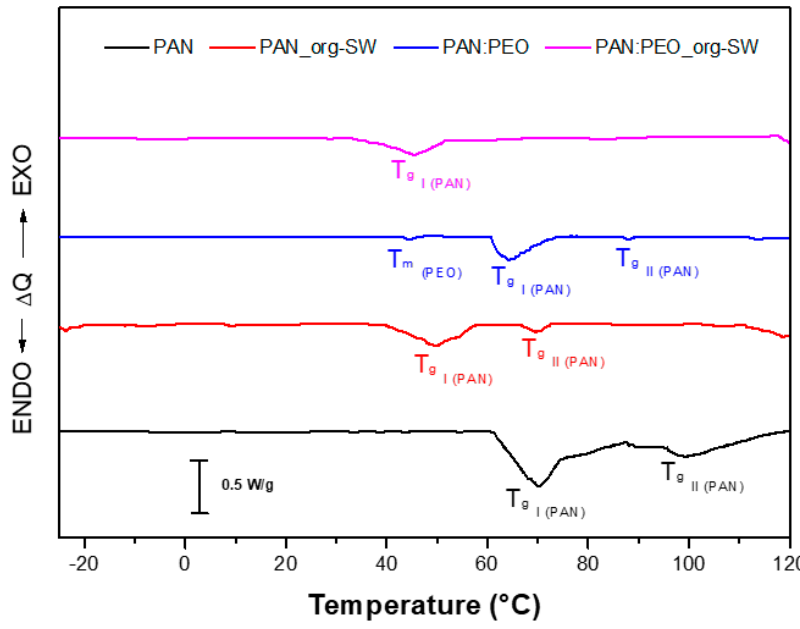
Figure 3. DCS thermograms of the GPEs membranes in the temperature range − 30 °C up to 120 °C, with a scan rate of 10 °C min − 1 .